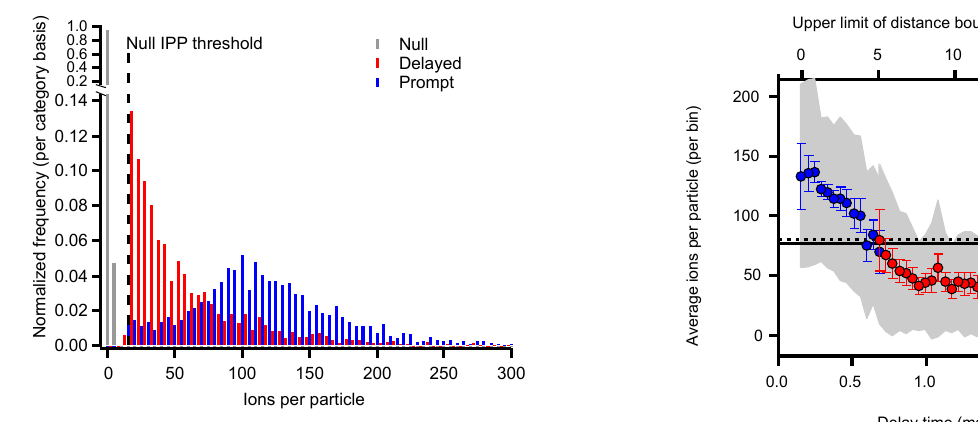
Figure 5. Histogram of ions per particle for null, delayed, and prompt SOA particles. Histogram of ions per particle for null (gray), delayed (red), and prompt (blue) particle categories for 370nm SOA particles. The y axis is the frequency of single-particle events within each category (in other words, all data for each category sum to 1). The histogram bars for the delayed category are offset (by five ions) on the x axis for clarity.